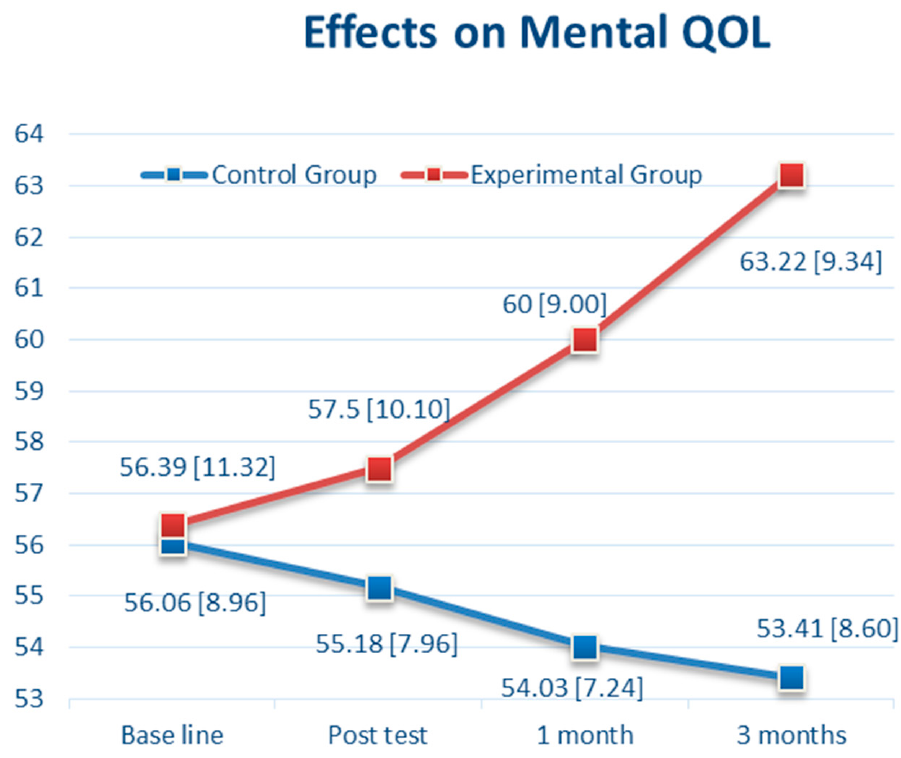
Figure 5. The Effects over Time of Cognitive Behavioral Therapy (CBT) on Mental Quality of Life